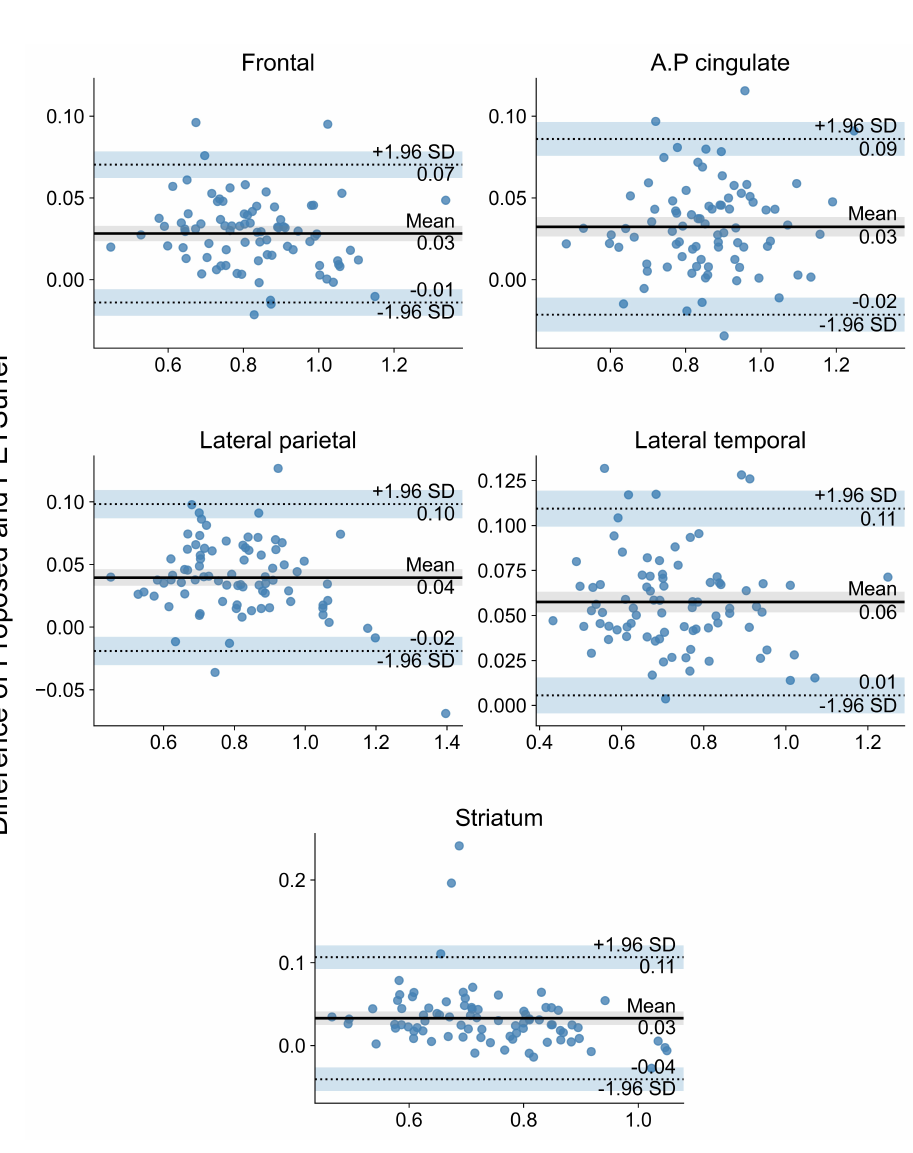
Figure A2. Bland–Altman plot for amyloidosis-positive subject for the comparison of our proposed method and PETSurfer. A.P. cigulate denotes anterior posterior cingulate